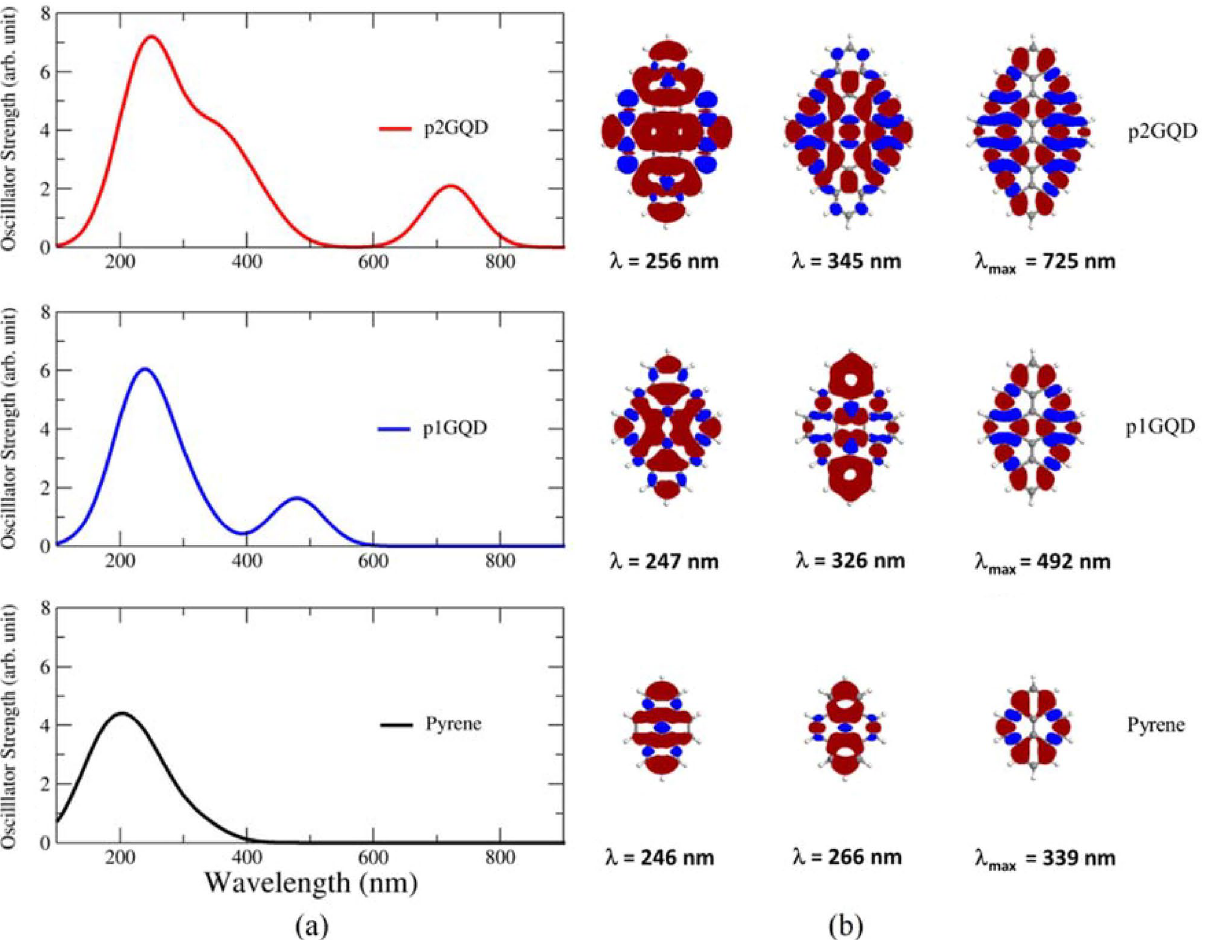
Figure 4. ( a ) Simulation result Excitation spectra of Pyrene (black), p1GQD (blue), and p2GQD (red) and ( b ). Charge difference density (CDD) map for the absorption peaks of Pyrene, p1GQD, and p2GQD. The blue color represents positive holes, and the red represents negative